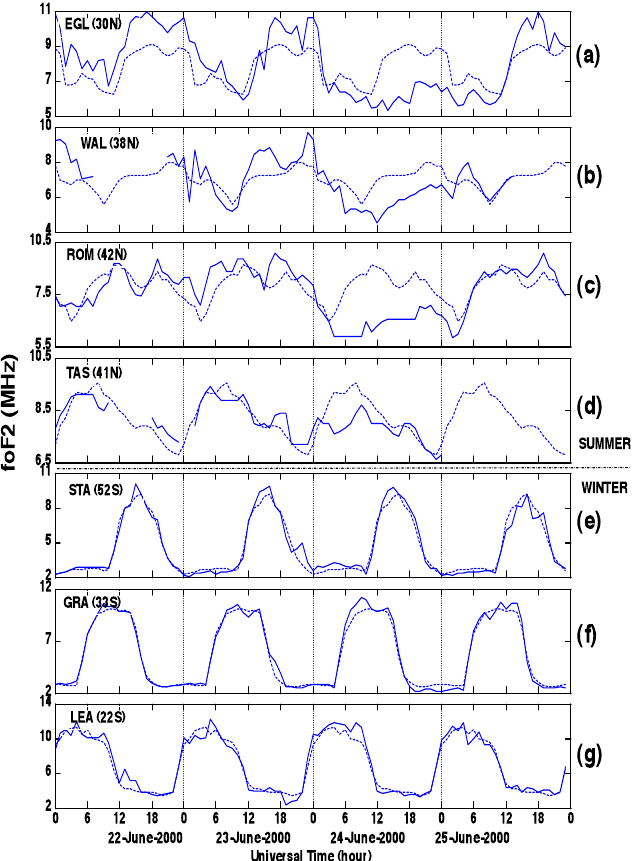
Figure 4. From top to bottom: The foF2 at the ionosondes for June 22-25, 2000: (a) Eglin AFB (EGL); (b) Wallops Is. (WAL); (c) Rome (Rom); (d) Tashkent (TAS); (e) Port Stanley (STA); (f) Grahamstown (GRA); and (g) Learmonth (LEA). Solid lines, observed foF2. Broken lines, reference foF2 (27-day running median).